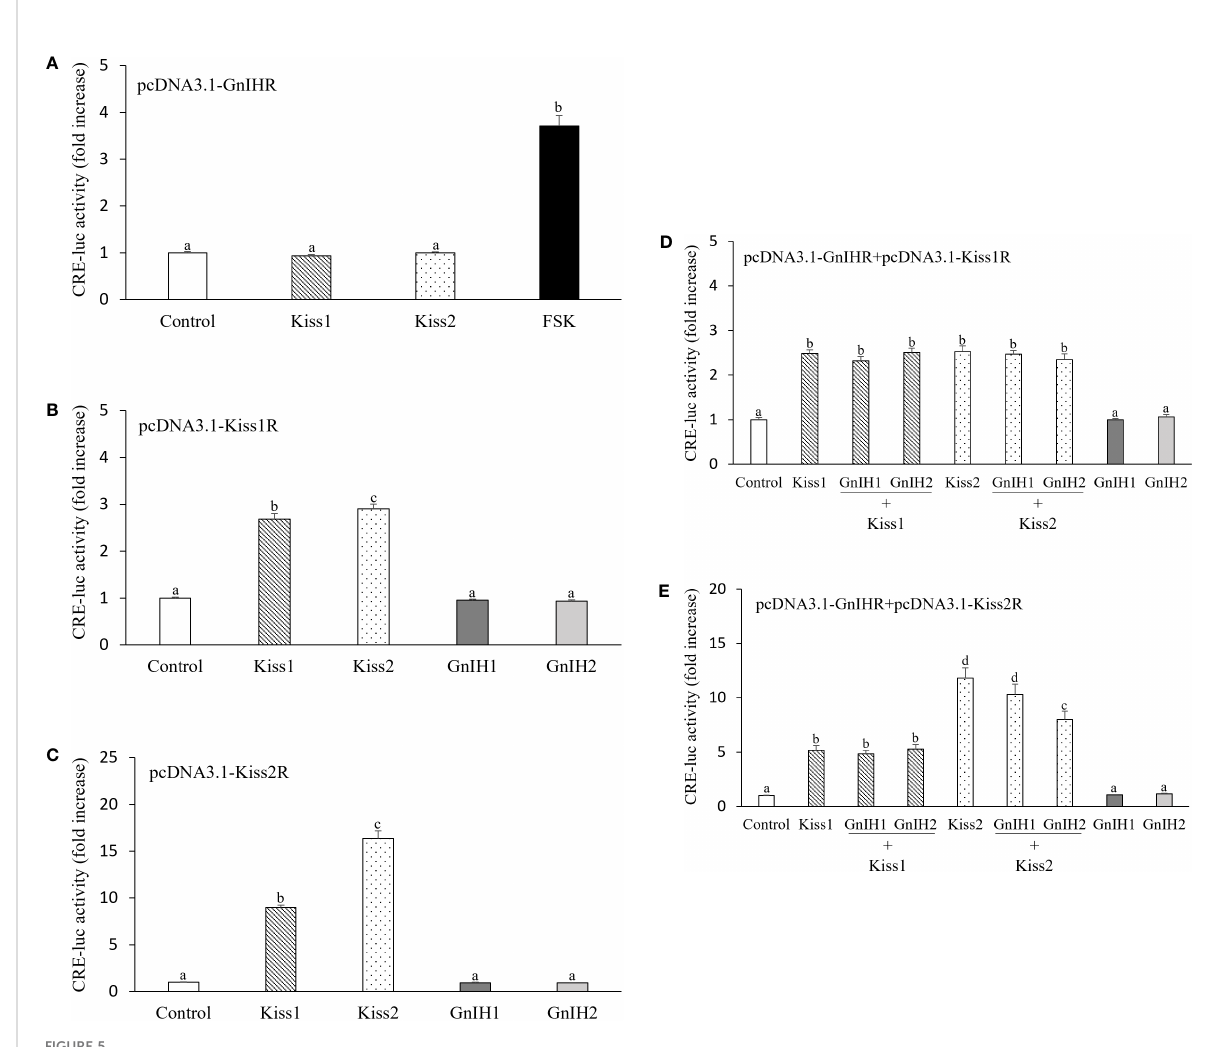
FIGURE 5 Interactions of GnIH on kisspeptin-elicited CRE-luc activity in COS-7 cells co-transfected with their cognate receptors. (A) CRE-luc activity in COS-7 cells expressing sea bass GnIHR and stimulated with 1 m M Kiss1 and Kiss2 or 10 m M FSK alone. (B, C) CRE-luc activity in COS-7 cells transfected with sea bass Kiss1R (B) or Kiss2R (C) and stimulated with 1 m M Kiss1, Kiss2, GnIH1 and GnIH2 alone. (D, E) CRE-luc activity in COS-7 cells co-transfected with sea bass GnIHR and Kiss1R (D) or Kiss2R (E) and stimulated with 1 m M Kiss1 and Kiss2 alone or in the presence of 1 m M GnIH peptides. Data are presented as the mean ± SEM (n=6). Different letters indicate statistically signi fi cant differences between mean values (ANOVA one-way p <